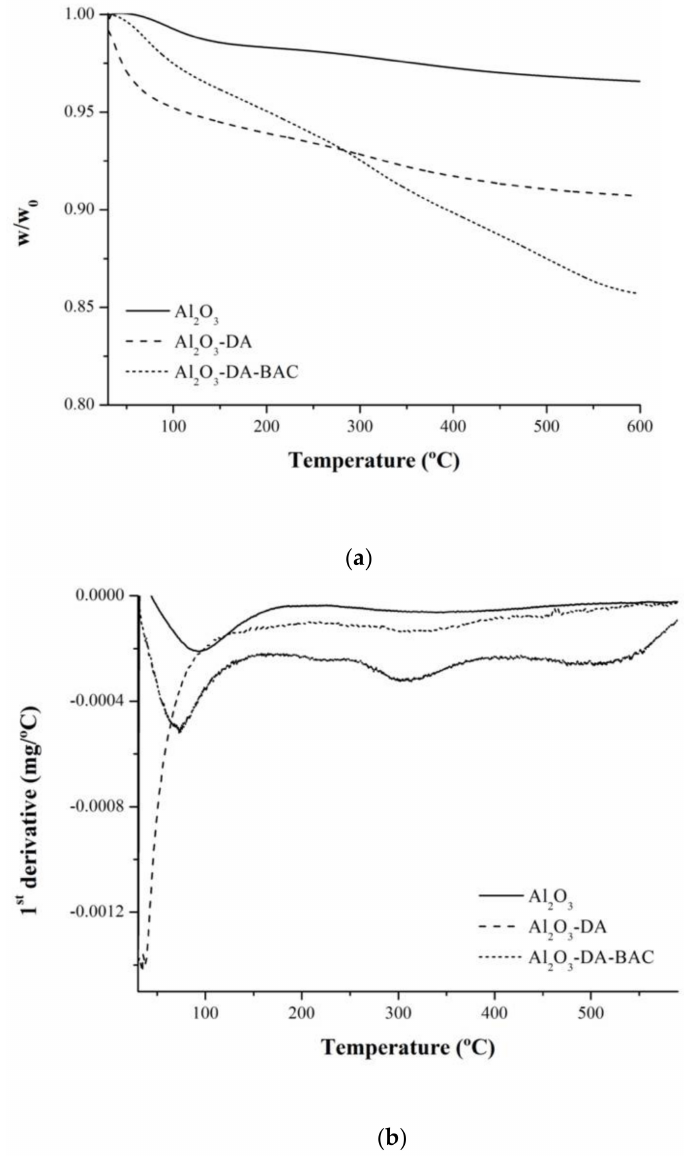
Figure 1. Thermogravimetric analysis, TG ( a ) and first derivative curve, DTG ( b ) of functionalized and Al 2 O 3